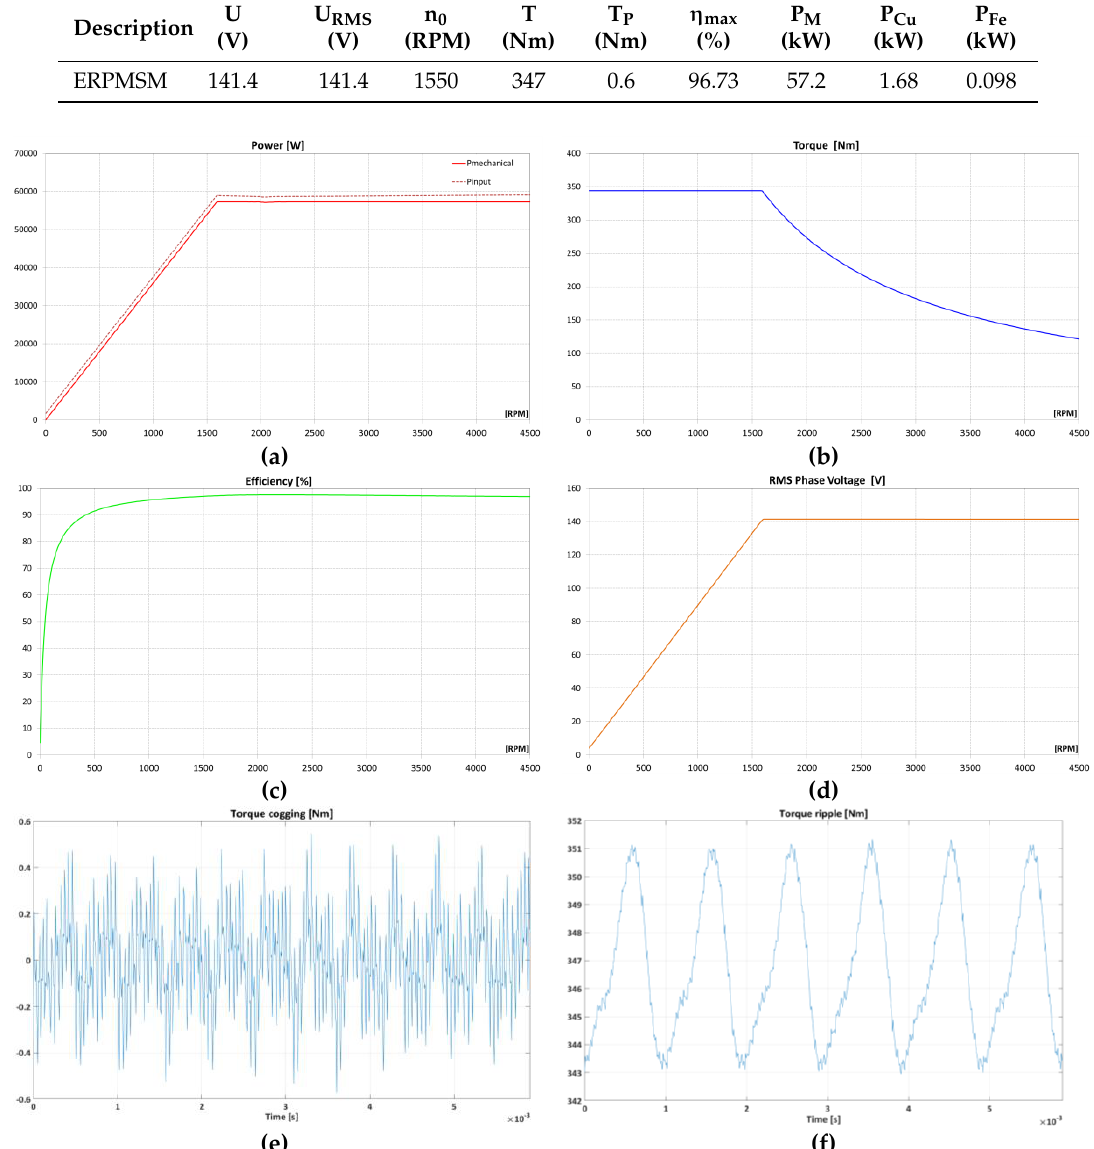
Figure 11. Results obtained from performance calculations: ( a ) motor power; ( b ) shaft torque; ( c ) efficiency; ( d ) effective phase voltage; ( e ) cogging torque; and ( f ) torque ripple.